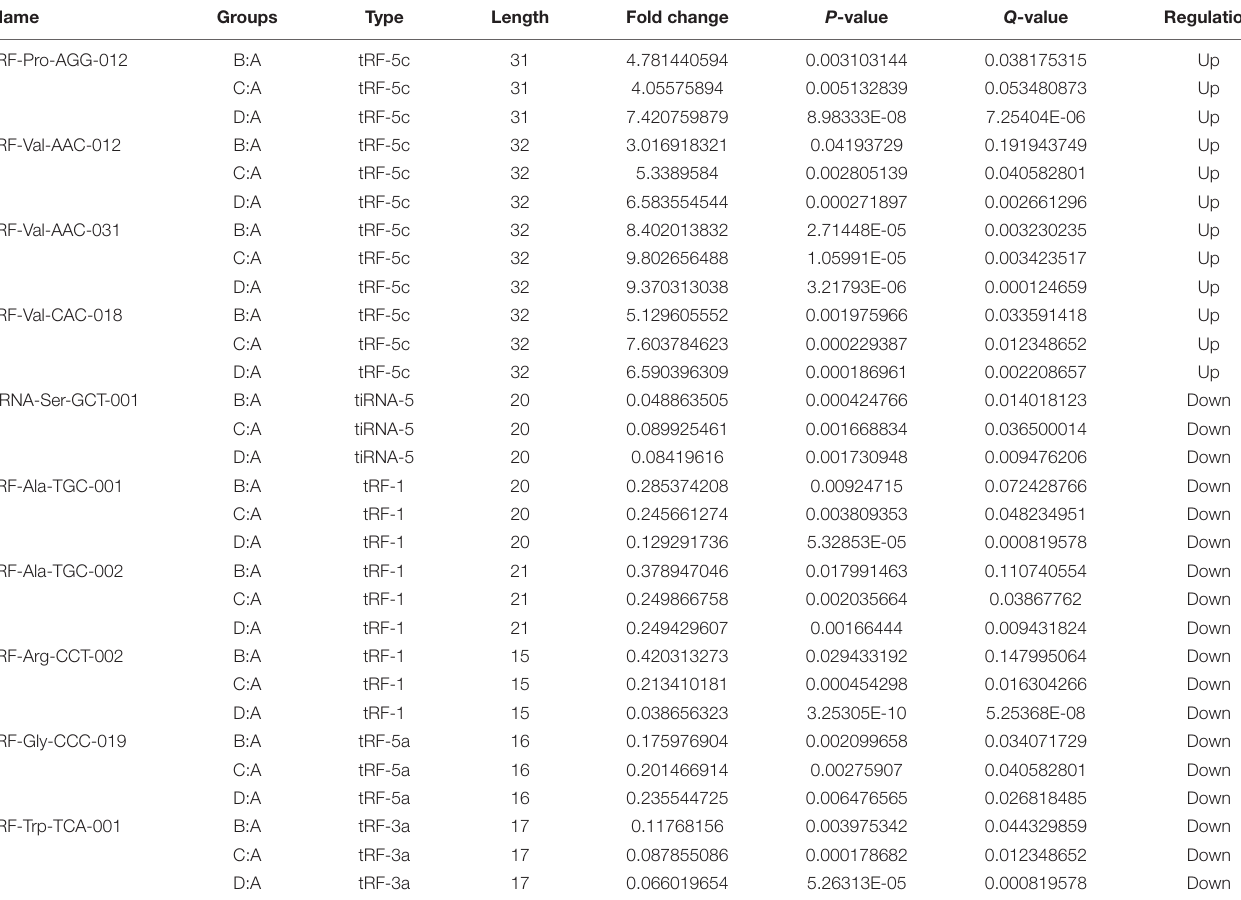
TABLE 1 | The candidate tRF & tiRNA for